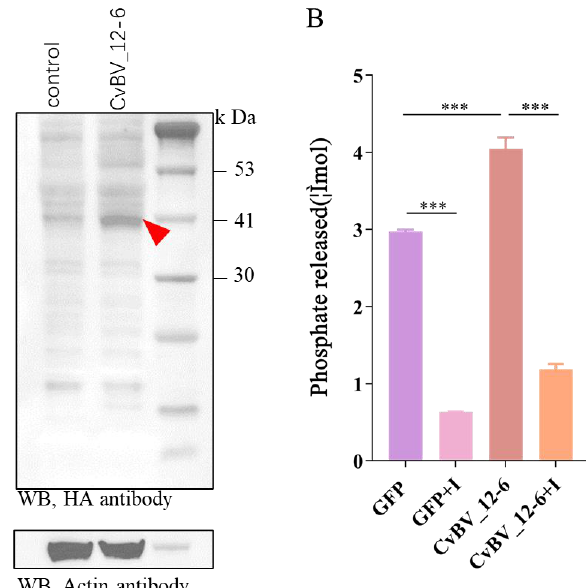
Figure 2. Eukaryotic expression of CvBV_12-6 and tyrosine phosphatase activity detection. ( A ) The expression of CvBV_12-6 in the Sf9 cell line was detected by western blotting using an HA tag monoclonal antibody, and actin was used as the internal control. ( B ) The tyrosine phosphatase activity of CvBV_12-6 in Sf9 cells was measured by the amount of phosphate released after the incubation of the total protein and synthesized phosphopeptides. The cell lysate was extracted 48 h post infection. The GFP was used as the negative control, and sodium vanadate was used as the protein tyrosine phosphatase inhibitor (I). Data are presented as the mean ± SD. Differences among samples were evaluated for significance via Tukey’s test (*** , significant difference at a p value < 0.001).